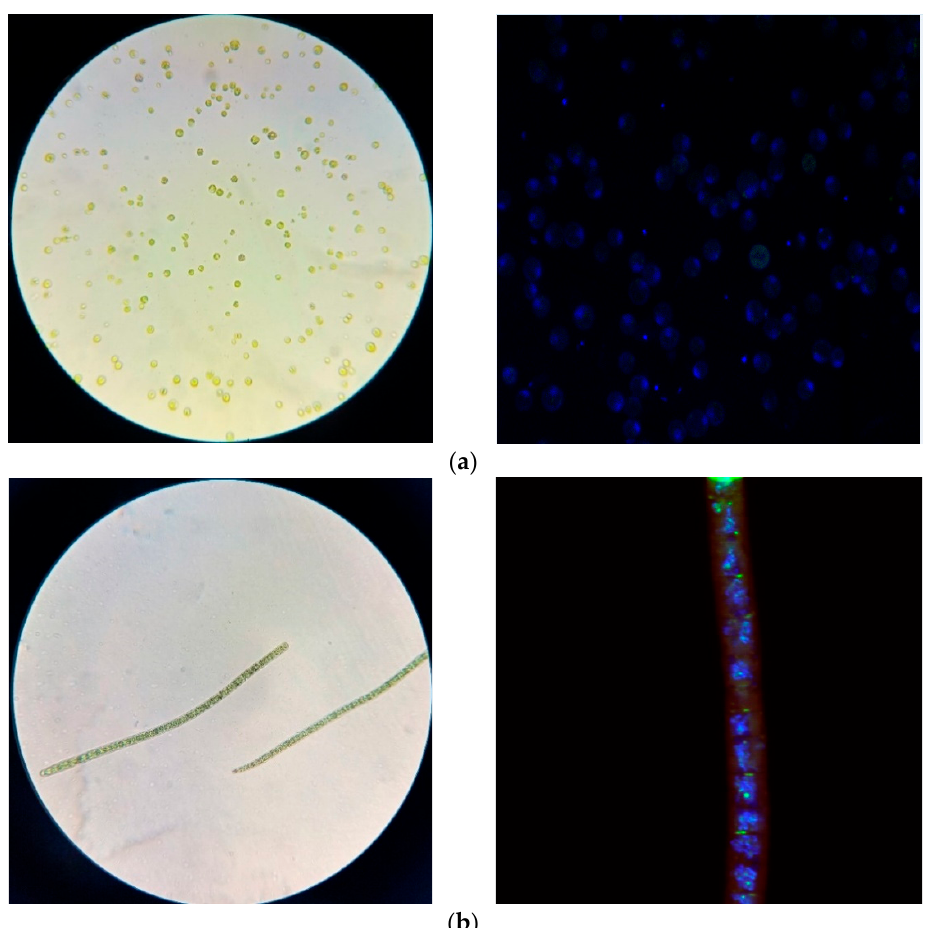
Figure 2. Light microscopy and fluorescence micrography (Bodipy and Dapi staining) of lipid inclusions in the cells of ( a ) C. Vulgaris ; ( b ) A. platensis